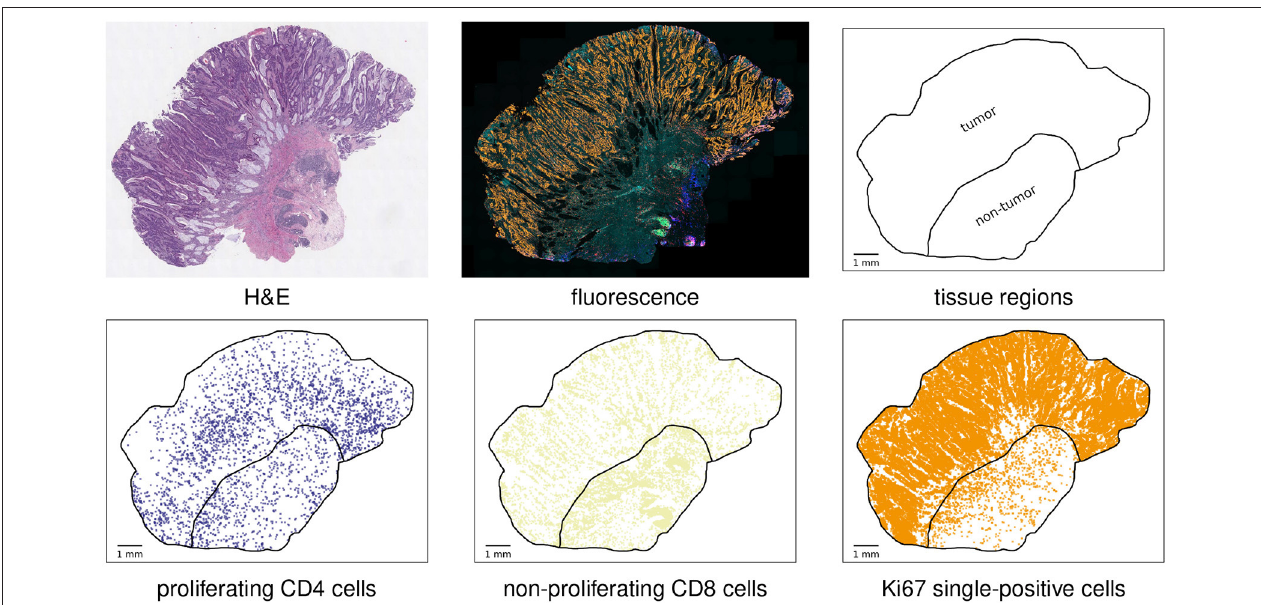
FIGURE 1 | Basic analysis workflow. Top row, from left to right: H&E-stained slide for visual assessment of the specimen; synthetic overlay of the fluorescence images of different cell protein stainings; automatically detected tissue and annotated tumor compartment of the tissue. Bottom row: visualization of three examples of detected cell object types. This case was classified as